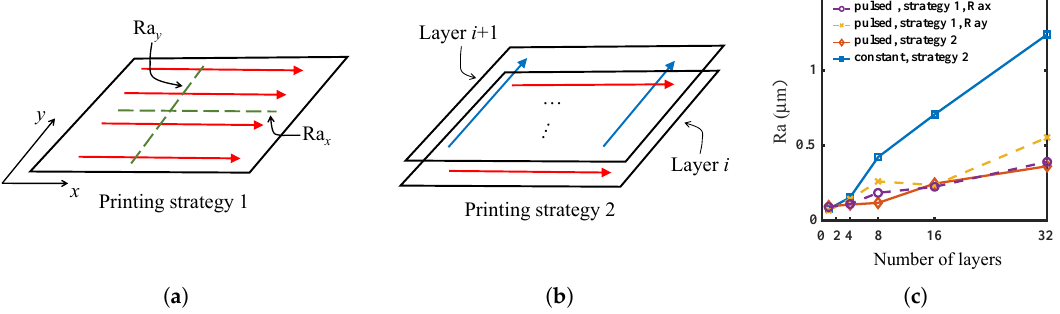
Figure 6. The average surface roughness, Ra, was investigated for two printing strategies. ( a ) Printing Strategy 1, where the print head moves along the x -axis for all layers. ( b ) Printing Strategy 2, where the printing direction rotates 90 ◦ after printing each layer. ( c ) Ra as a function of the number of deposition layers and printing strategies under pulsed and constant